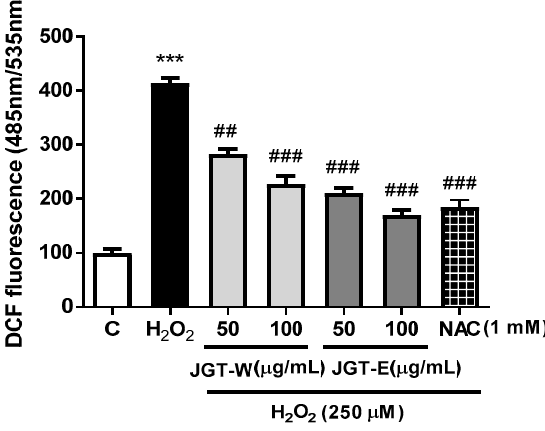
Figure 5. Effects of JGT-W and JGT-E extracts on viability of H 2 O 2 -treated C2C12 cells. NAC was positive control. Data are representative of three independent experiments and expressed as mean ± standard error of mean ( n = 7). *** p < 0.001 vs. control; ## p < 0.01, ### p < 0.001 vs. viability of H 2 O 2 - treated cells. JGT-E, 30% ( w/v ) ethanol extract of Jakyakgamcho-tang; JGT-W, Jakyakgamcho-tang water